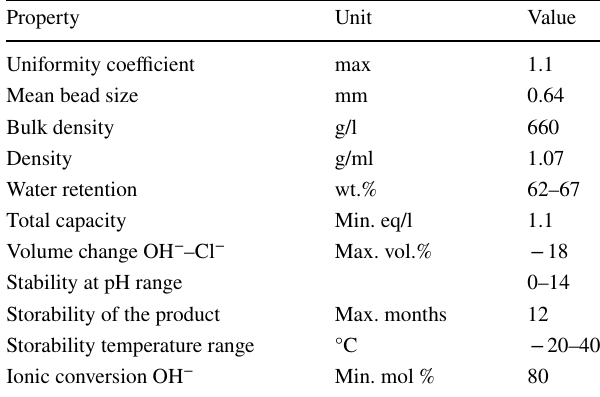
Table 2 Physical and chemical characteristics of anionic